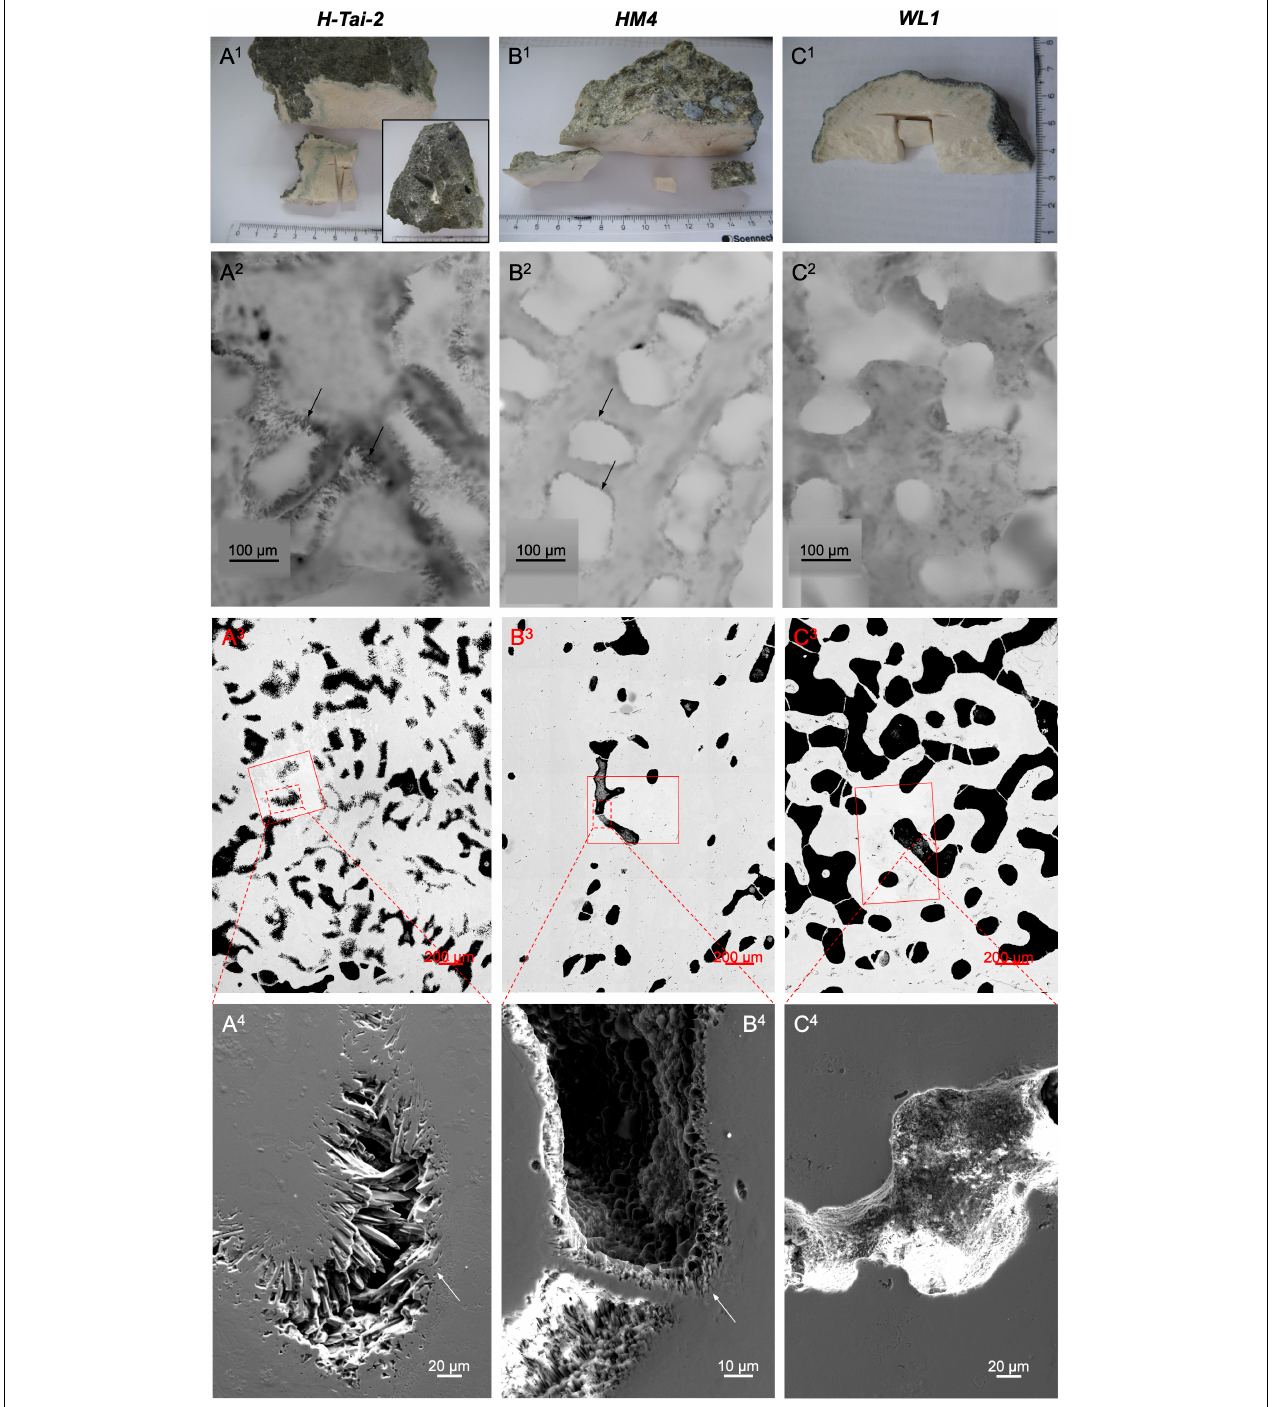
FIGURE 2 | Photographs ( A 1 –C 1 panels), light microscope (A 2 –C 2 ) , backscatter (A 3 –C 3 ) and scanning electron microscope (A 4 –C 4 ) images of the selected coral sample examples: (A) H-Tai-2; (B) HM4; and (C) WL1. Photographs show the retrieved samples from the field and the coral sampling approach during which small cubes were cut out. Diagenetic alterations are already visible from the light microscope images in the samples H-Tai-2 (A) and HM4 (B) as secondary aragonite needles precipitated within skeletal voids (indicated by black arrows), with the pores and needles being comparatively larger in the sample H-Tai-2 than in HM4. The third sample WL1 (C) is considered pristine as no secondary aragonite needles were found within the pores. Position of the EMP analyzed areas (as in Figure 5 ) is indicated in the backscatter images with solid line red rectangles, and dashed line red rectangles indicate the position of the close up images from scanning electron microscope (SEM; bottommost